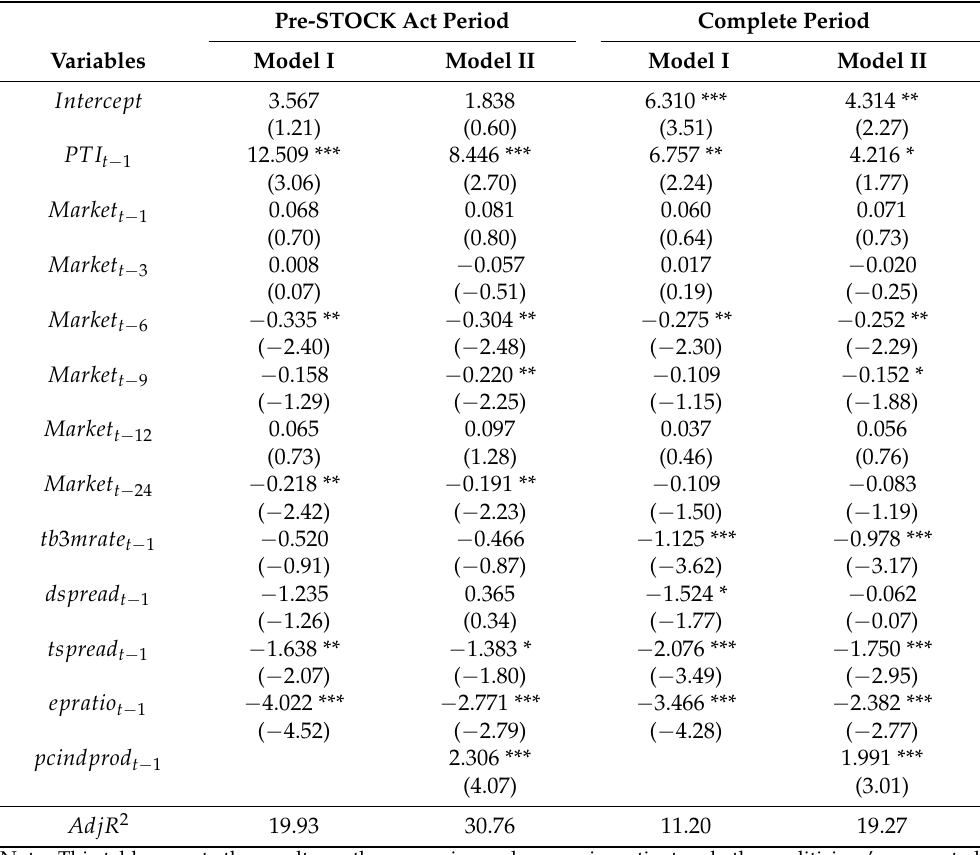
Table 5. Person-based trading index and value-weighted market